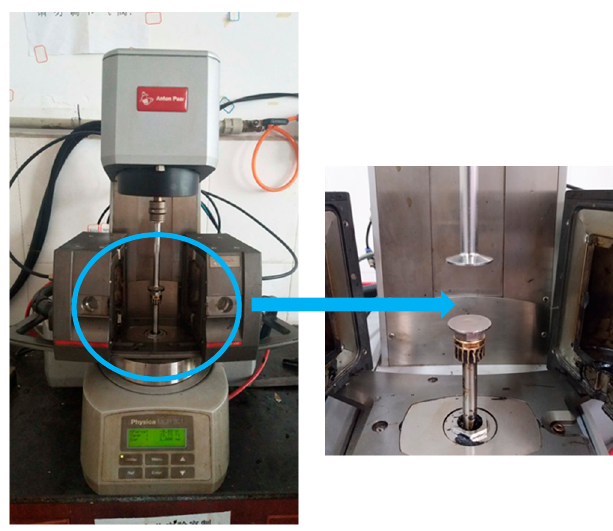
Figure 2. Dynamic shear rheometer (DSR) test equipment.